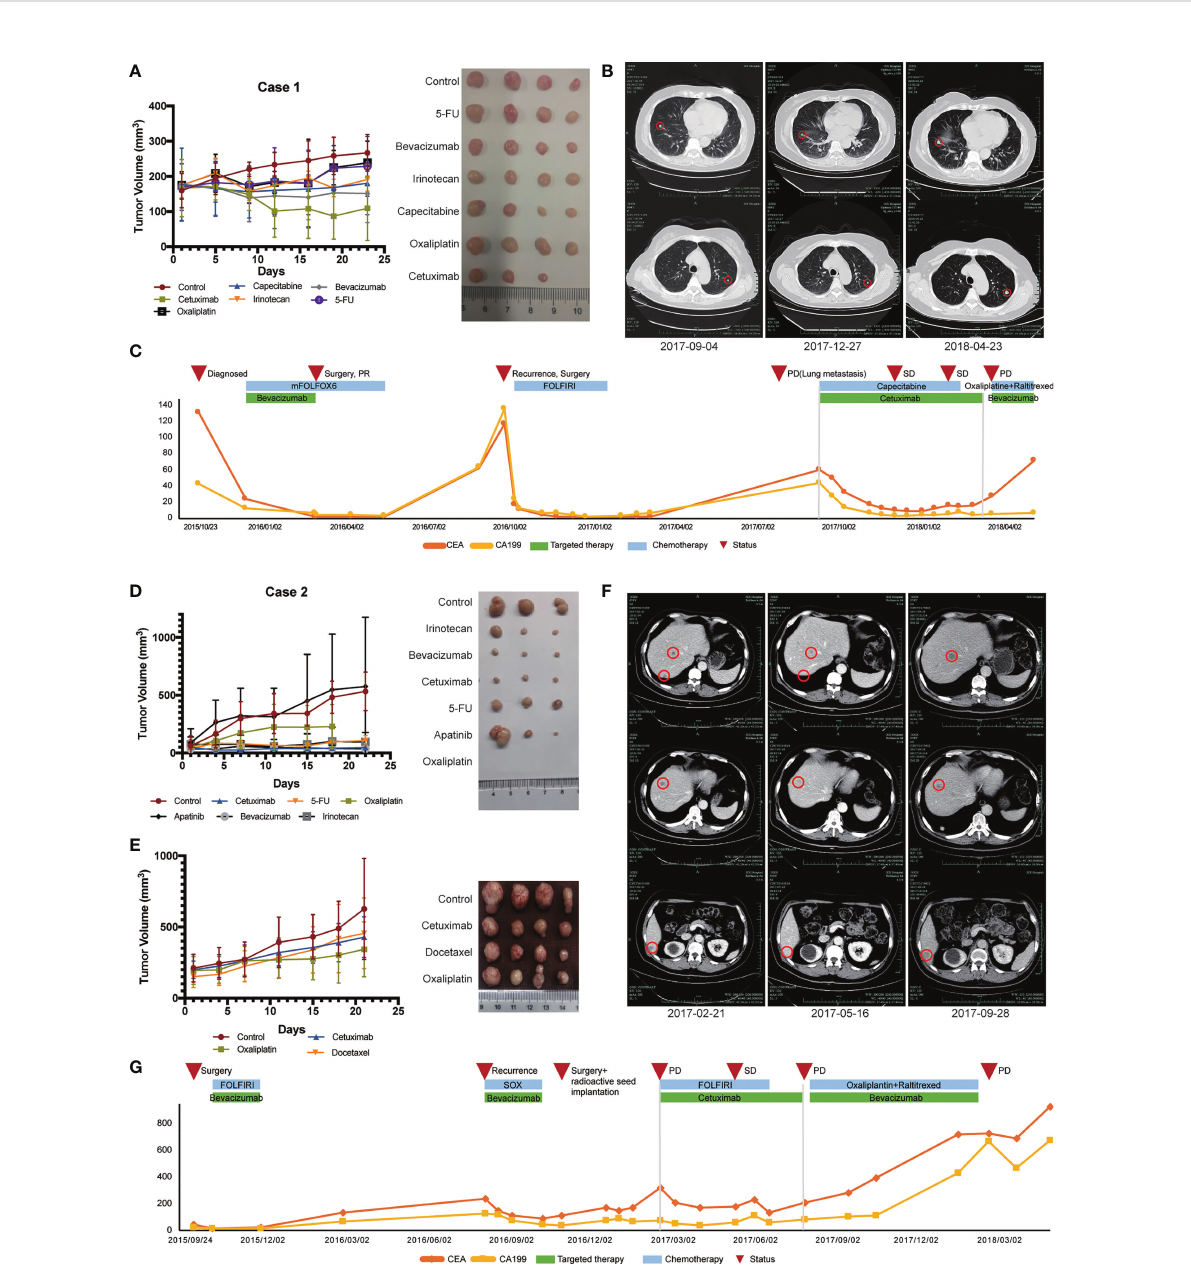
FIGURE 3 Therapeutic response of PDX models and corresponding patients. (A) In vivo drug sensitivity of Case 1 with KRAS mutation using PDX models. (B) Imaging changes of lung metastasis during treatment in Case 1. (C) Changes of serum tumor markers during treatment in Case 1. (D) The fi rst in vivo drug sensitivity of Case 2 with KRAS mutation using PDX models. (E) In vivo drug sensitivity of Case 2 with KRAS mutation using PDX models after recurrence. (F) Imaging changes of liver metastasis during Ftreatment in Case 2. (G) Changes of serum tumor markers during treatment in Case